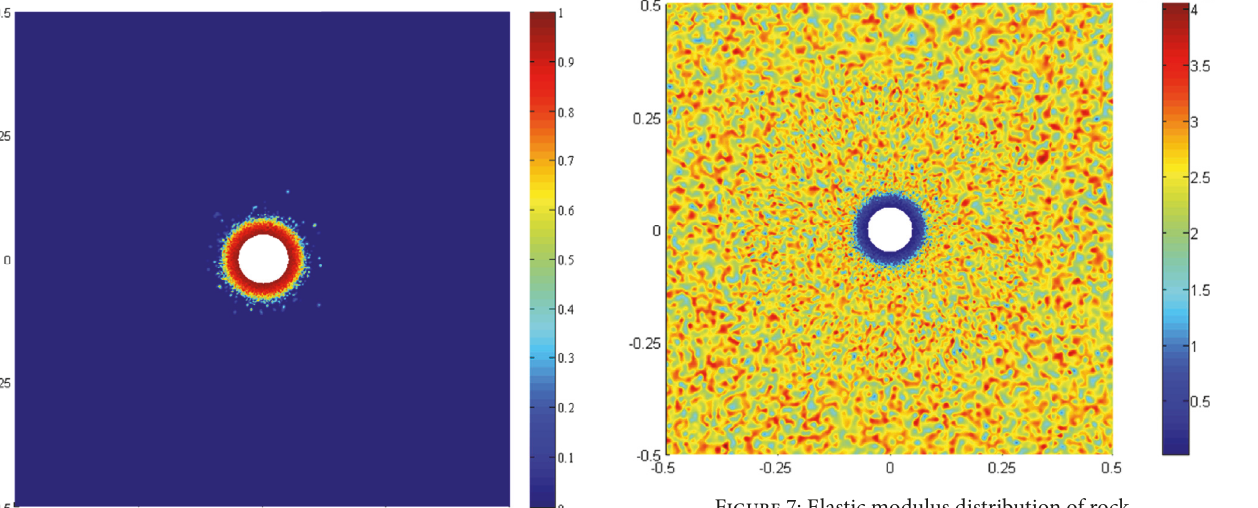
Figure 7: Elastic modulus distribution of